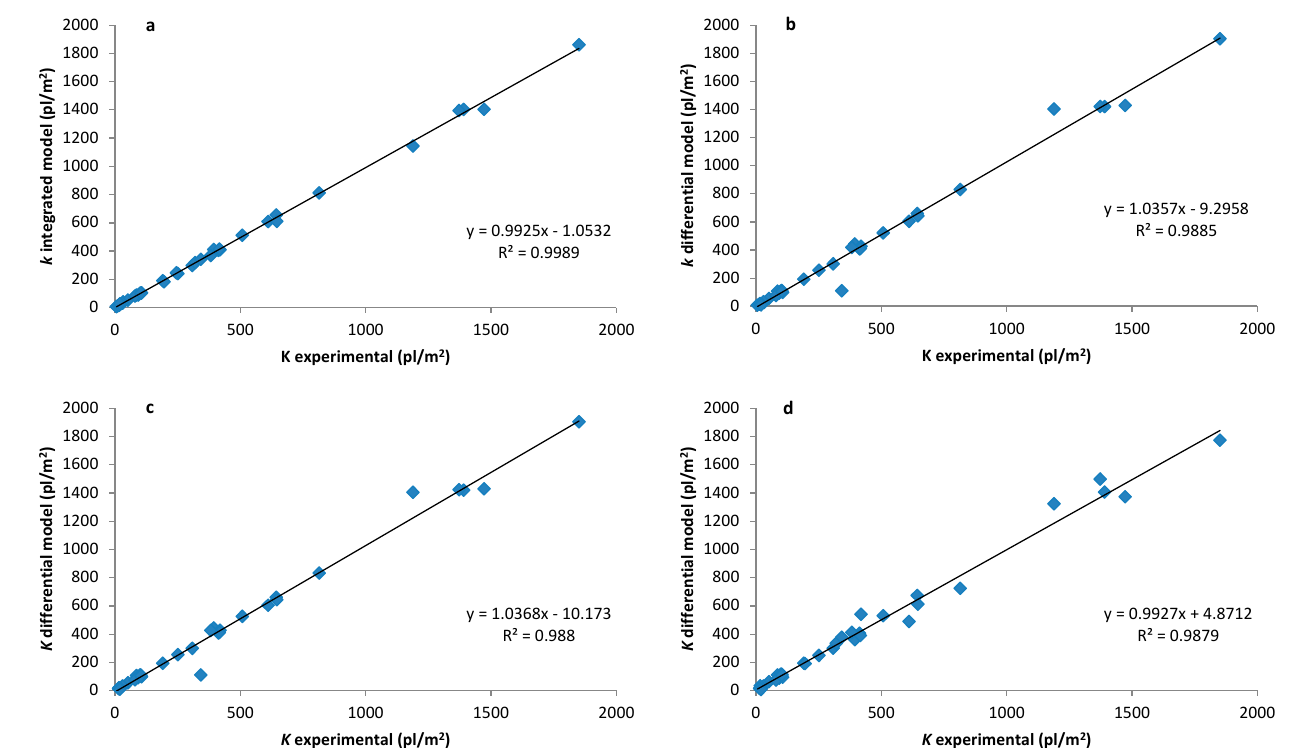
Figure 2. Relationships between the maximum weed seedling population observed in the field ( K experimental) and the predicted weed seedling population according to different approaches: ( a ) the integrated approach (n = 39); ( b ) the differential approach with filters applied to the emergence and the derivative of the emergence and criteria to cease counts being derivative <0.03 (n = 35); ( c ) the differential approach with filters applied to the emergence and derivative of the emergence and criteria to cease counts being derivative <0.05 (n = 33) and ( d ) the differential approach with the filter applied to the derivative of emergence and criteria to cease counts being derivative <0.05 (n = 35).